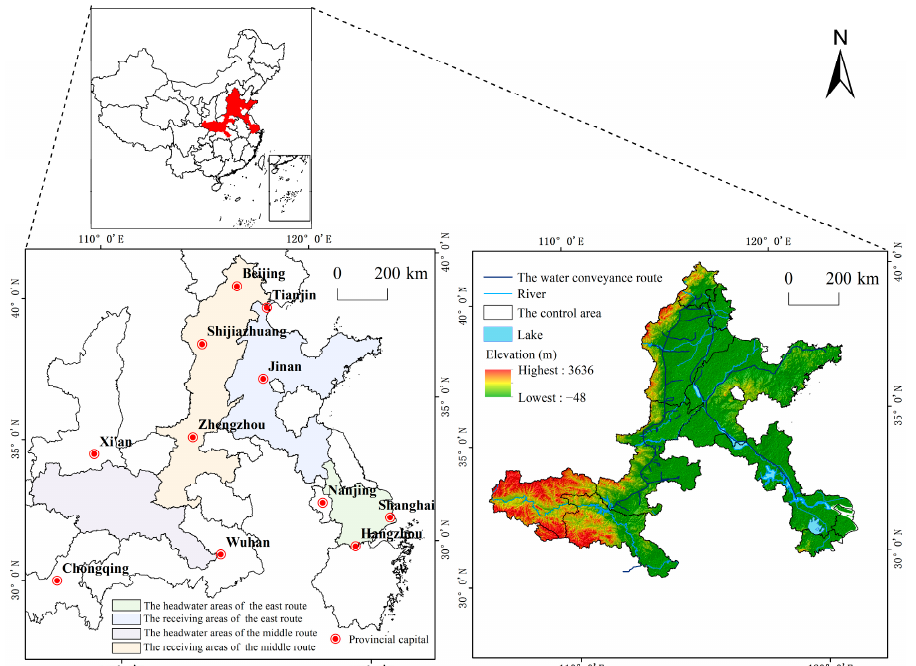
Figure 1. Location of the study area.